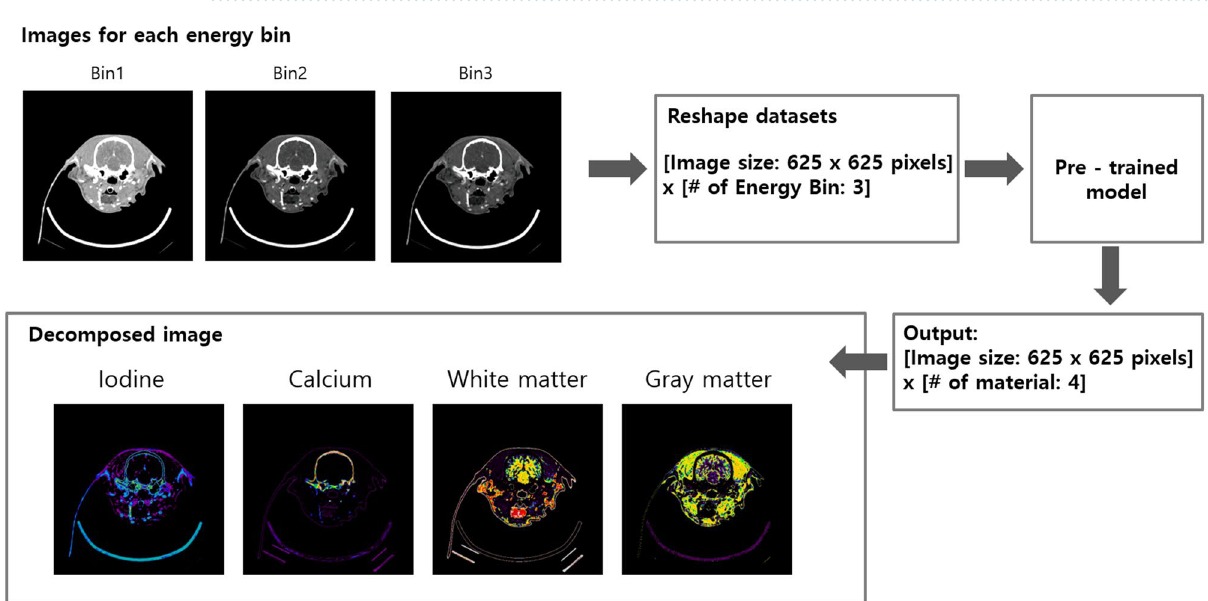
Figure 3. ( a ) Illustration of the structure for networks. The model consists of eight hidden layers with ReLU function. Images are shown as examples. ( b ) Cost function.